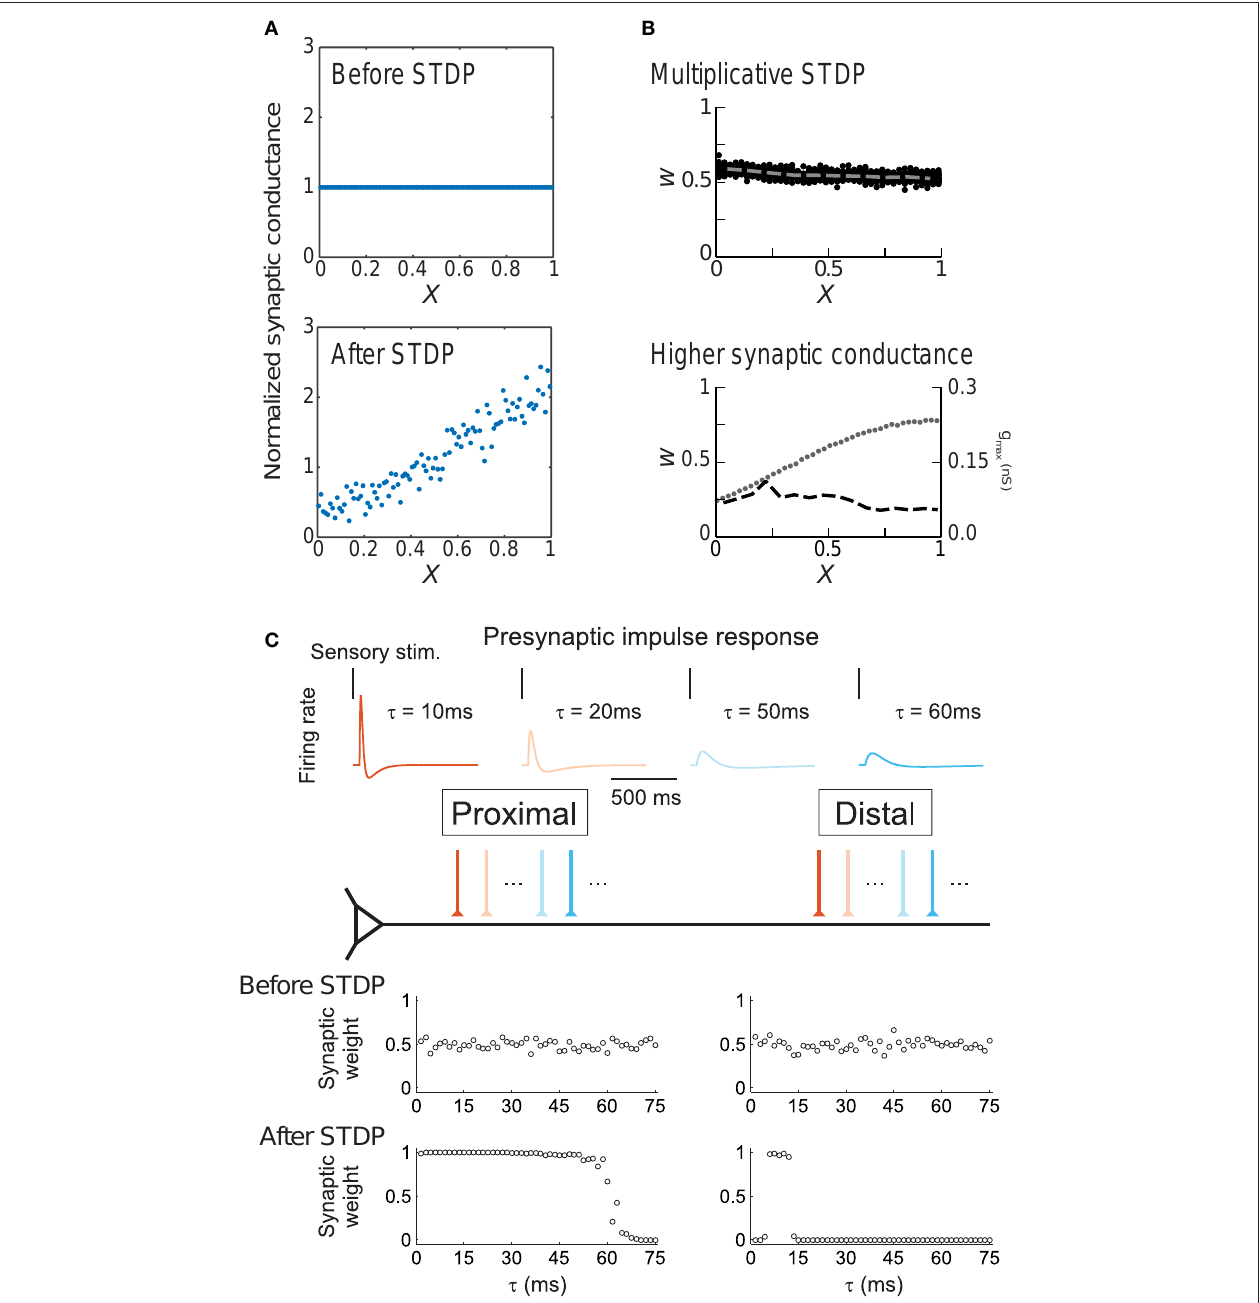
conductances g (bottom). Dashed lines indicate average synaptic strengths; max dots indicate g . From Gidon and Segev (2009). (C) In layer 2/3 neurons, max location-dependent STDP selects for transient distal inputs. Top, example presynaptic responses to brief sensory stimuli. Warmer colors indicate more transient responses ( τ < 15 ms). Bottom, synaptic inputs before and after induction of STDP. From Froemke et al.